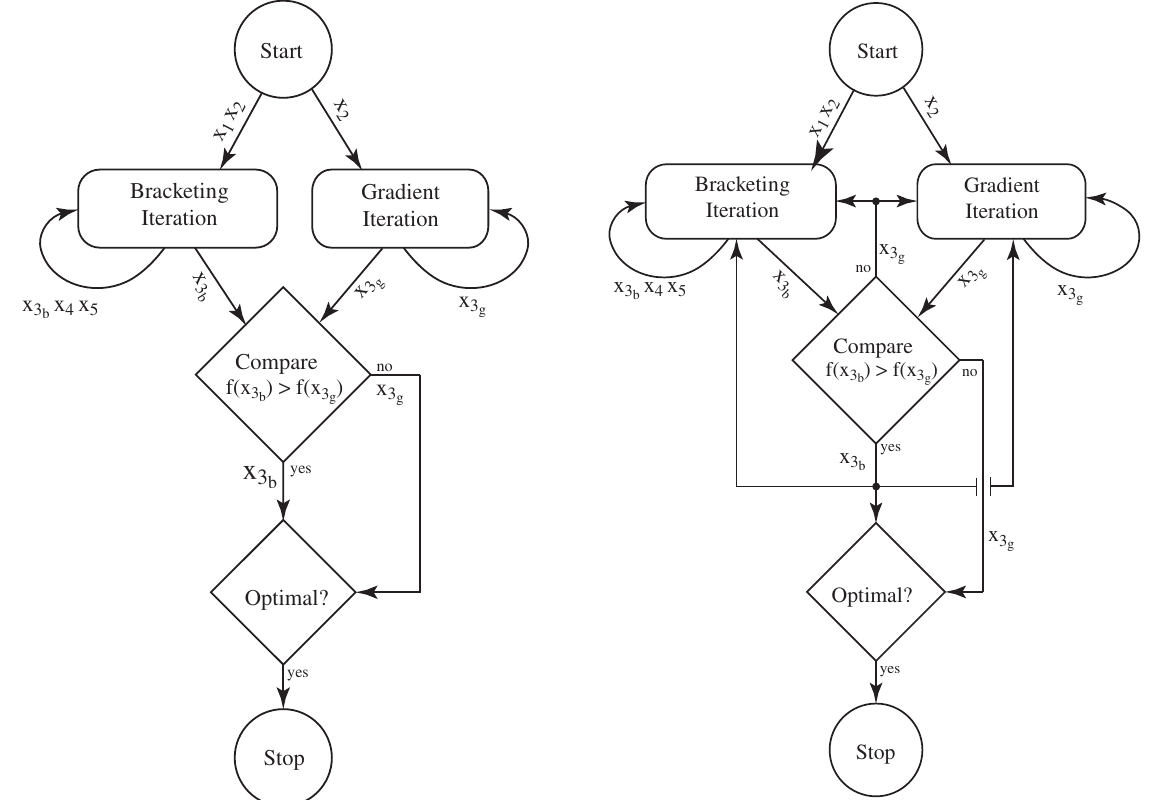
Fig. 9. Extensive communication cognitive optimizer. Communica- tion occurs between the